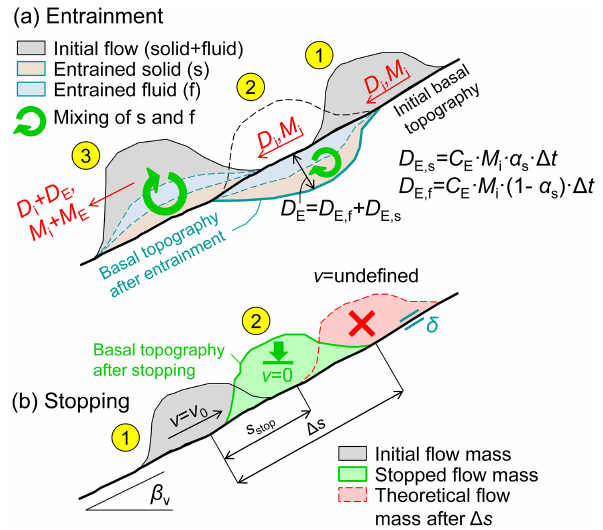
Figure 3. Interactions of the flow with the basal topography: (a) en- trainment, assuming that H Emax , s and H Emax , f are not limiting; D i : total initial flow depth (s + f); M i : total initial momentum (s + f); D E : entrained depth; M E : total increase in momentum due to entrainment (s + f). Panel (b) indicates stopping and deposition. Both panels represent sections along the steepest slope of the basal topography. Note that stopping and deposition usually occur on less inclined slopes than drawn in (b) which represents upslope move-